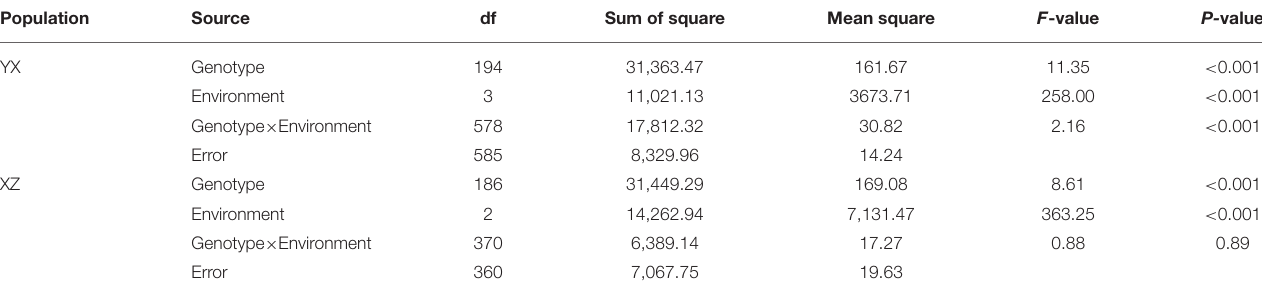
TABLE 2 | Two-way ANOVA of variance for plant height in two RIL populations across multiple environments. Population